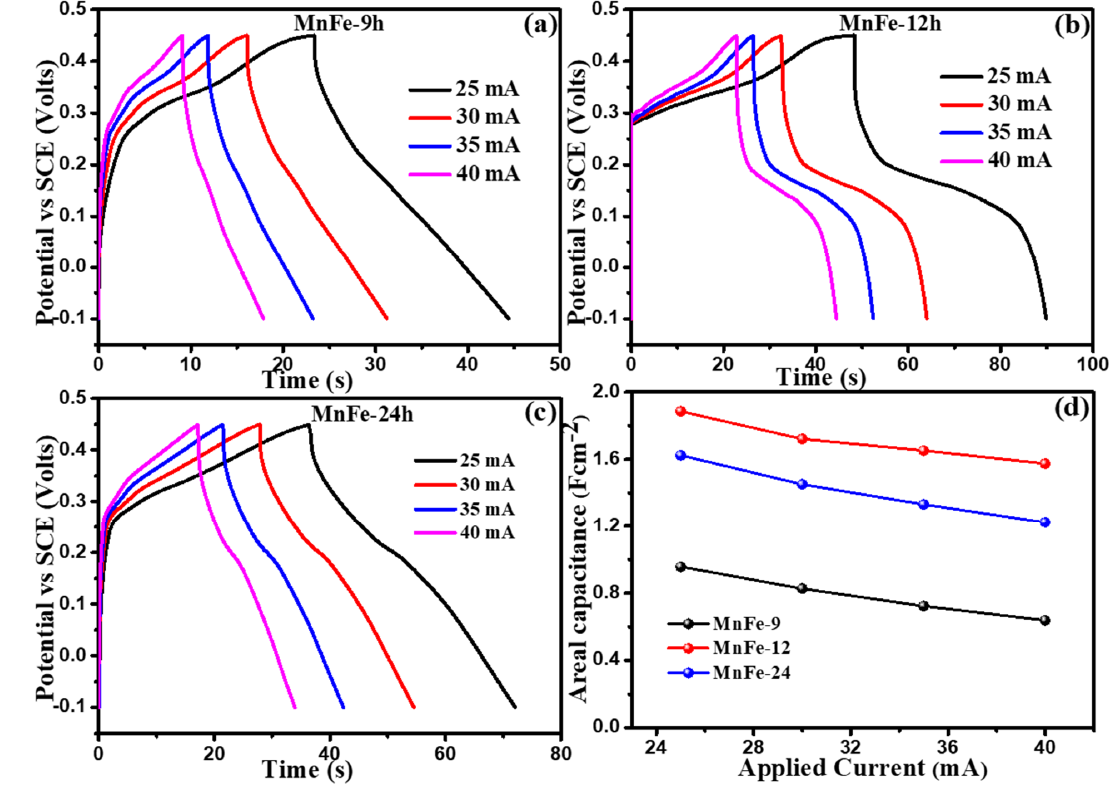
Figure 7. Galvanostatic charge / discharge (GCD) curves of ( a ) MnFe-9h, ( b ) MnFe-12h, and ( c ) MnFe-24h, recorded at different applied currents. ( d ) Variation of areal capacitance with respect to applied current.